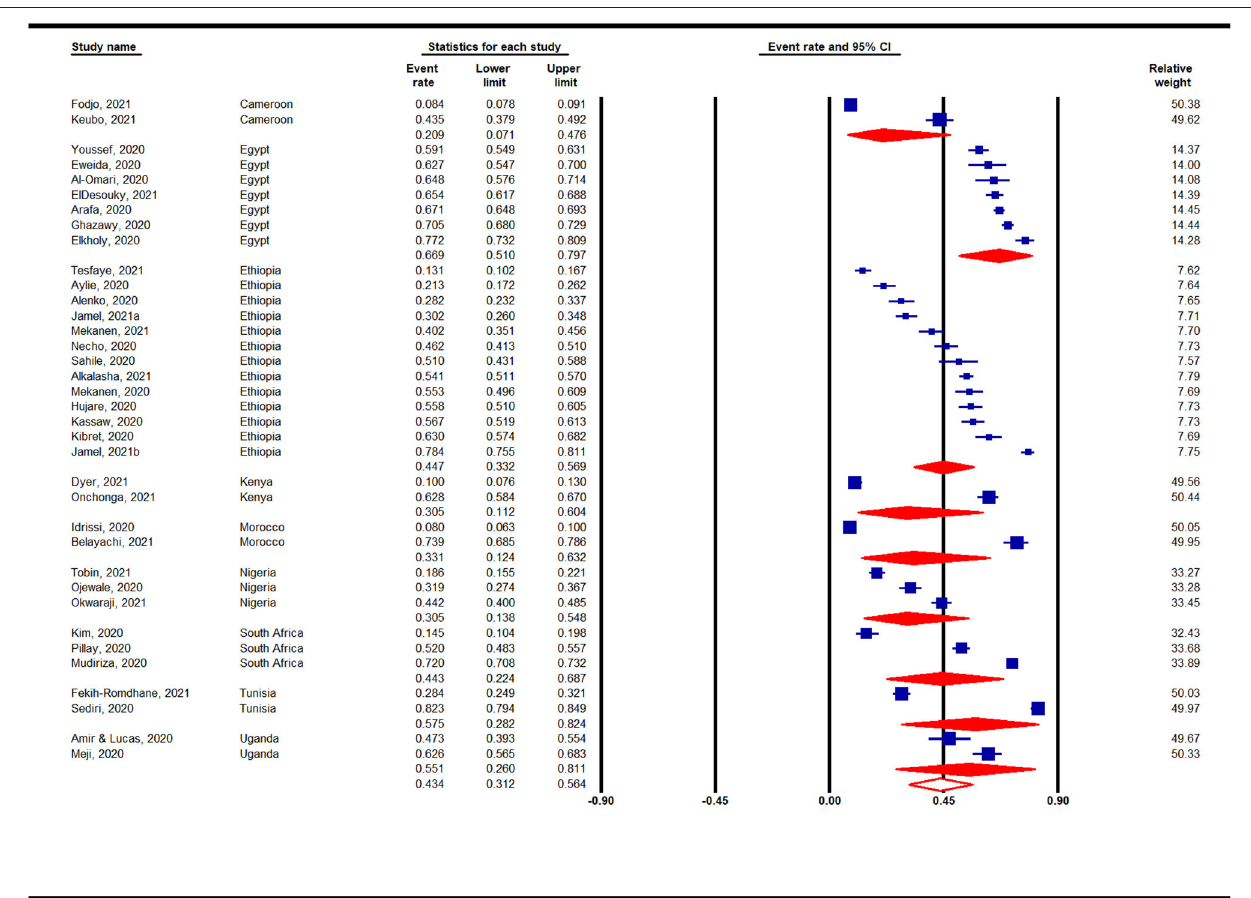
FIGURE 6 | Prevalence of depression in Africa by countries during the COVID-19